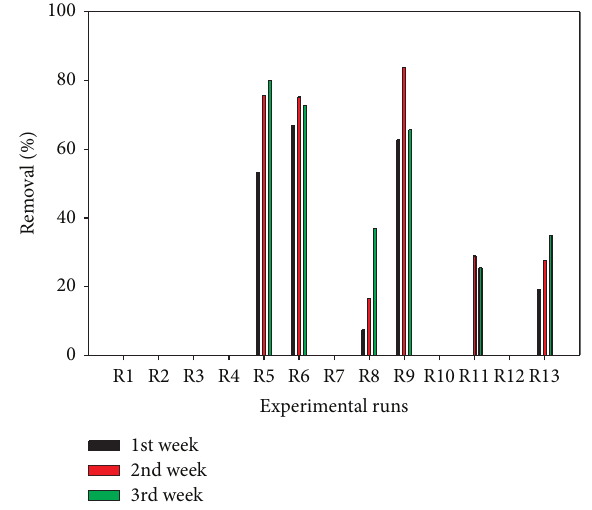
Figure 13: Weekly percentage removal of trivalent Cr for 13